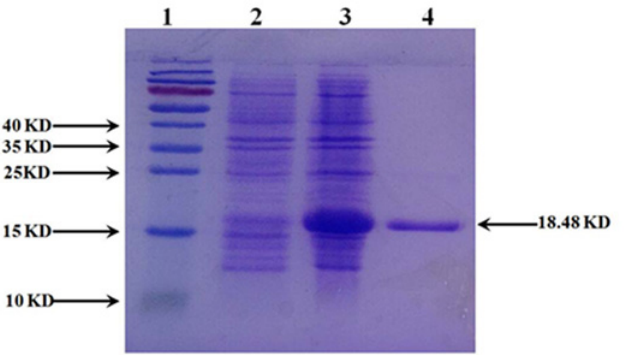
Fig 1. SDS-PAGE analysis of the CDA expression. E . coli BL21 (DE3) cells containing pET-28a- cdd were grown and induced with 1 mM IPTG. The cells were sonicated and then centrifuged to divide into two fractions, soluble and insoluble fractions. Soluble fraction was then purified using Ni-NTA agarose. Lane 1, size markers; Lane 2, total proteins of the uninduced cells; Lane 3, total proteins of the IPTG-induced cells; Lane 4, purified protein of